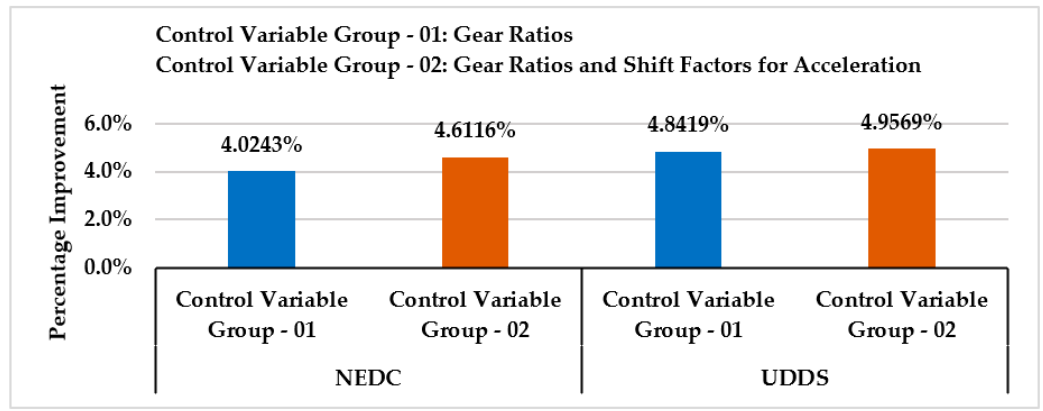
Figure 11. Energy-saving through optimization of gear ratios and shift factors of a gearshift schedule for acceleration combinedly for a two-speed transmission system in an EV model on NEDC and UDDS drive cycles.